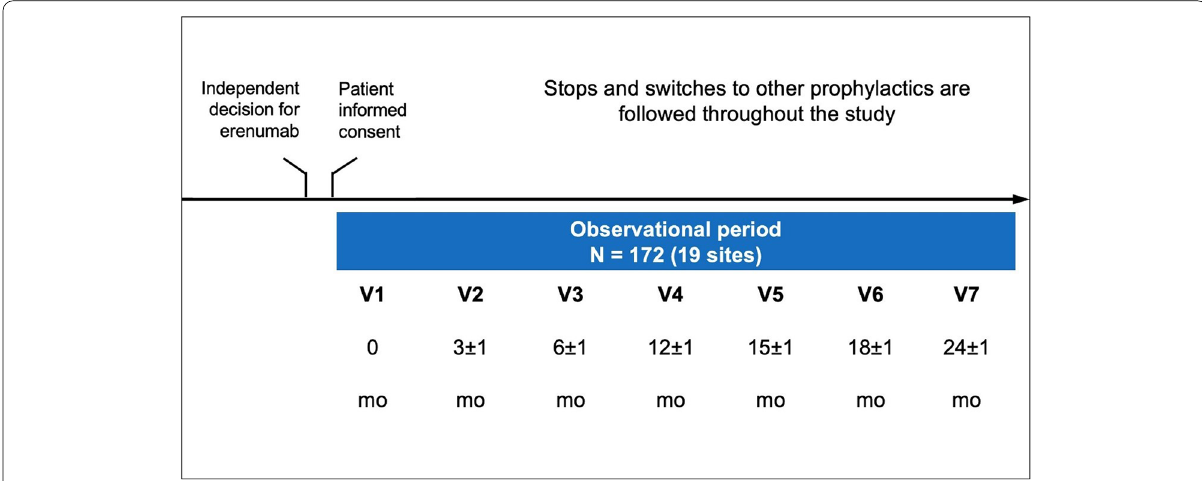
Fig. 1 Study design and visit schedule. mo: month; V: